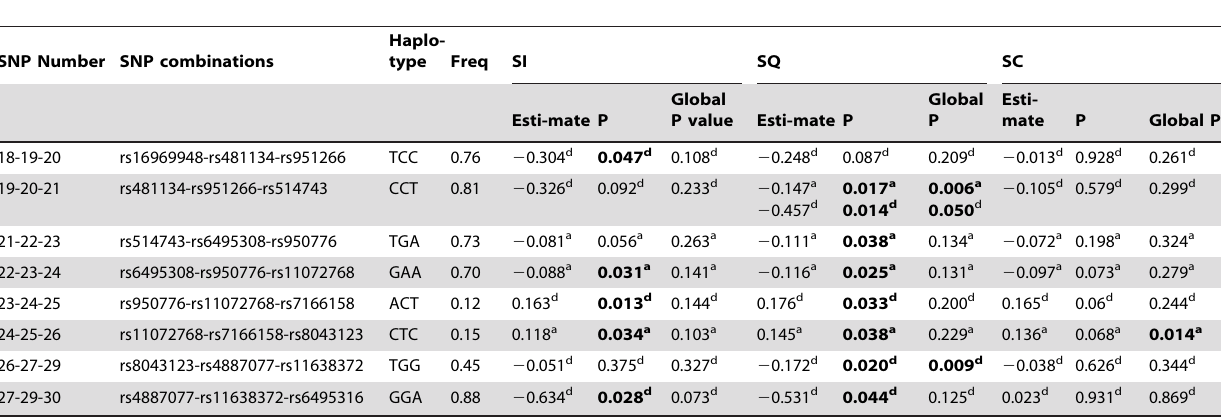
Table 3. Statistics estimates and P values for major haplotypes showing significant associations at the 0.05 level with at least one smoking-related phenotype under the additive and dominant models in the total sample.